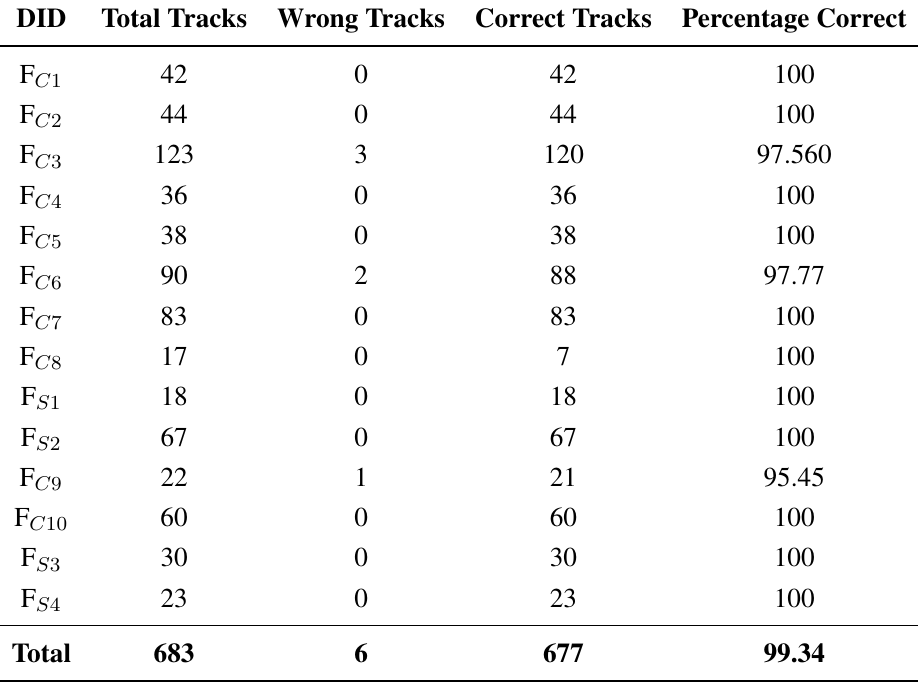
Figure 10. ( a ) The tracking algorithm fails to associate storms (missed association) at t and t ; ( b ) storms at t and t are incorrectly associated; ( c ) the storm at t 4 3 4 associated with the storm at t , due to violating the maximum speed limitation. 4 Table 5. Tracking evaluation of our procedure for all